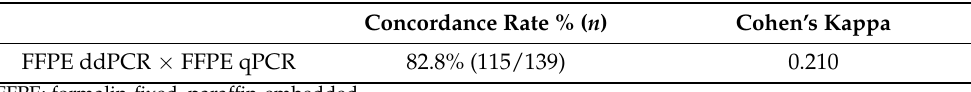
FFPE: formalin-fixed, paraffin-embedded.